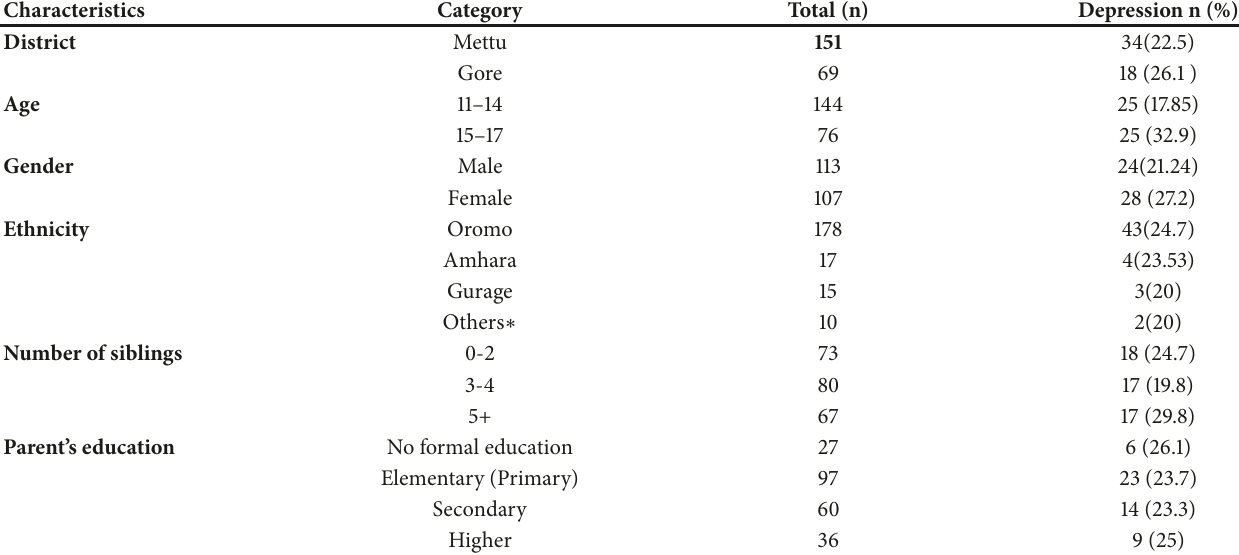
Table 2: Distributions of sociodemographic characteristics and depression among orphans in orphanages of Ilu Abba Bor Zone, 2016.